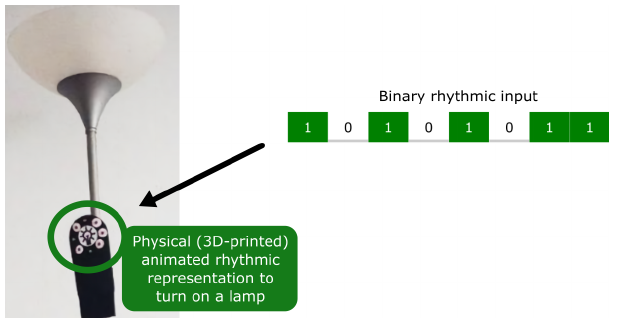
Figure 1. How rhythmic-synchronization-based interaction works: an animated control shows a rhythm, and user can select it by matching corresponding rhythm, e.g., using a binary sensor as a button to mark rhythm. In example, the rhythmic sequence is shown by a physical control using a series of LEDs arranged in a circular way. Once user synchronizes with given rhythmic sequence, lamp turns on.